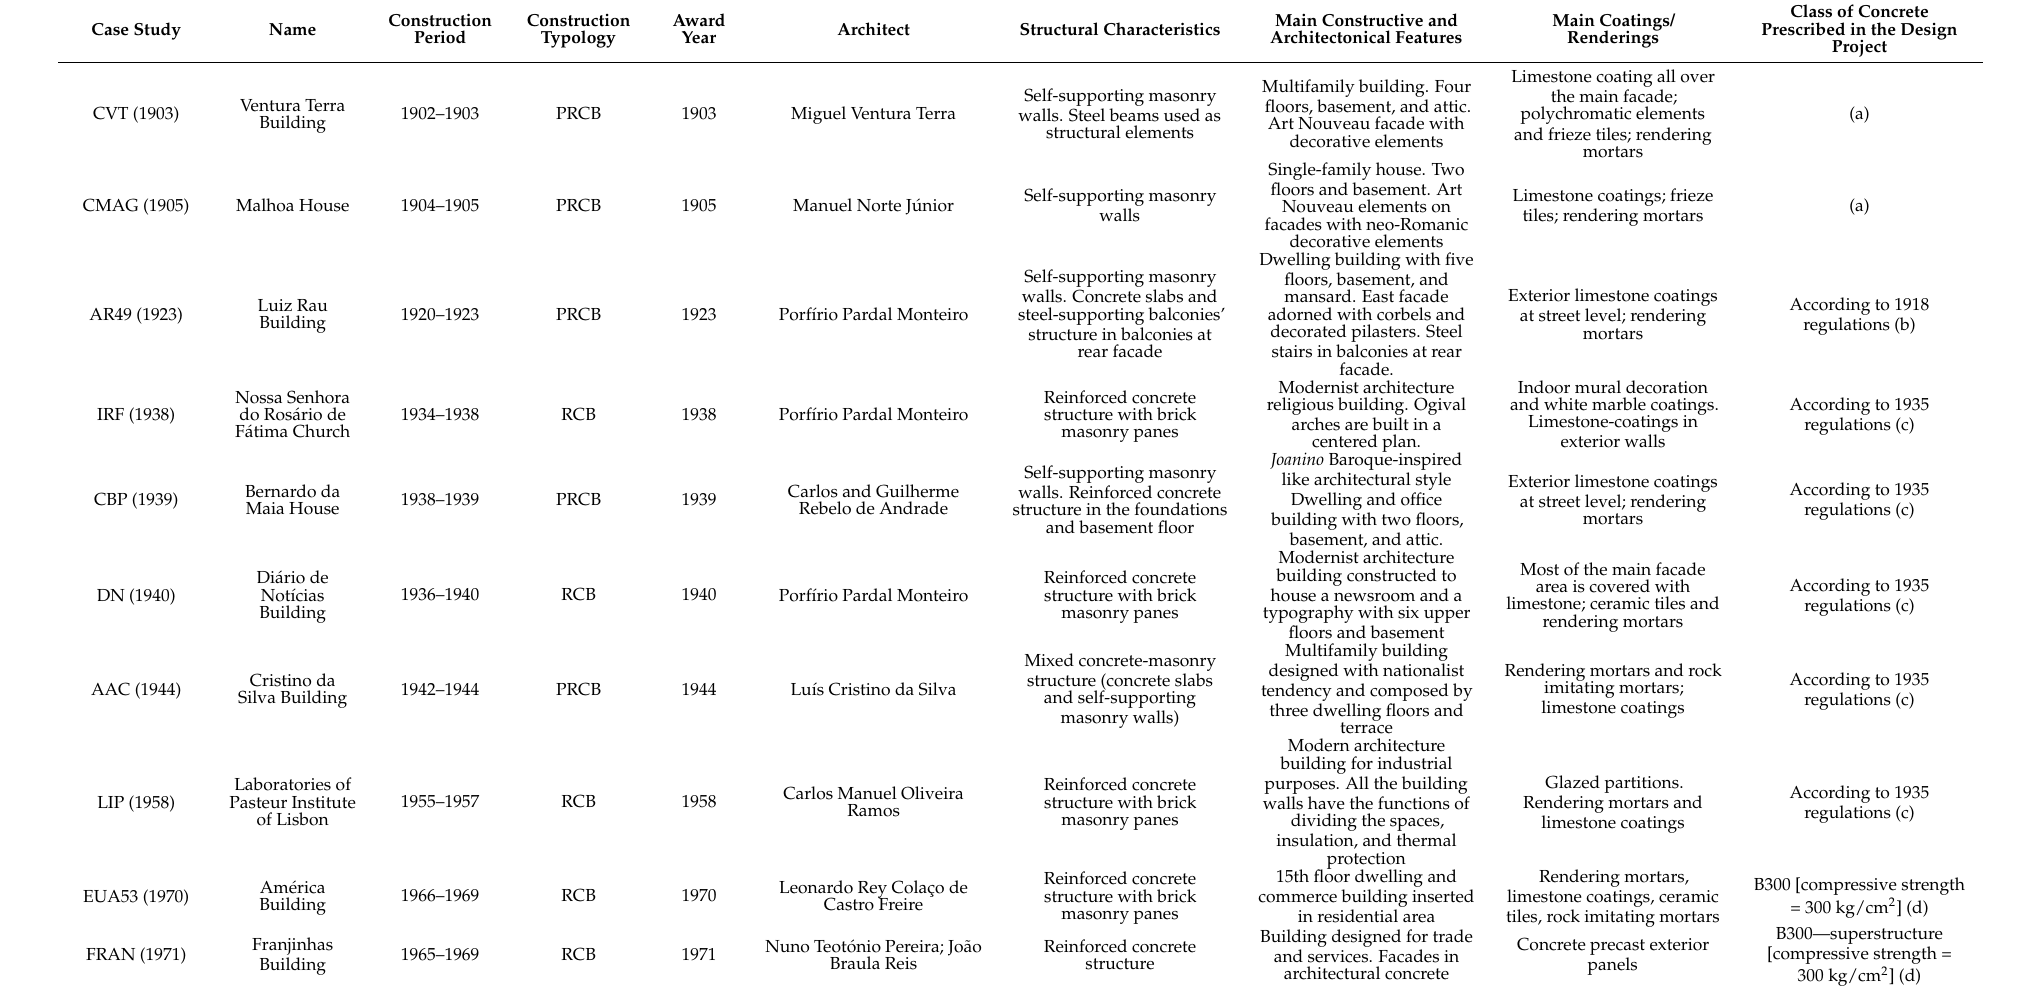
Table 1. Summary of case studies’ main constructive